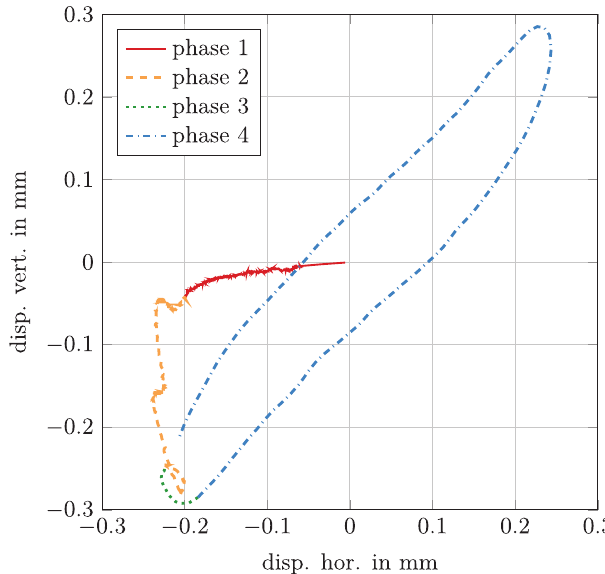
Figure 8. Vertical displacement over horizontal displacement 15 mm from the plucked